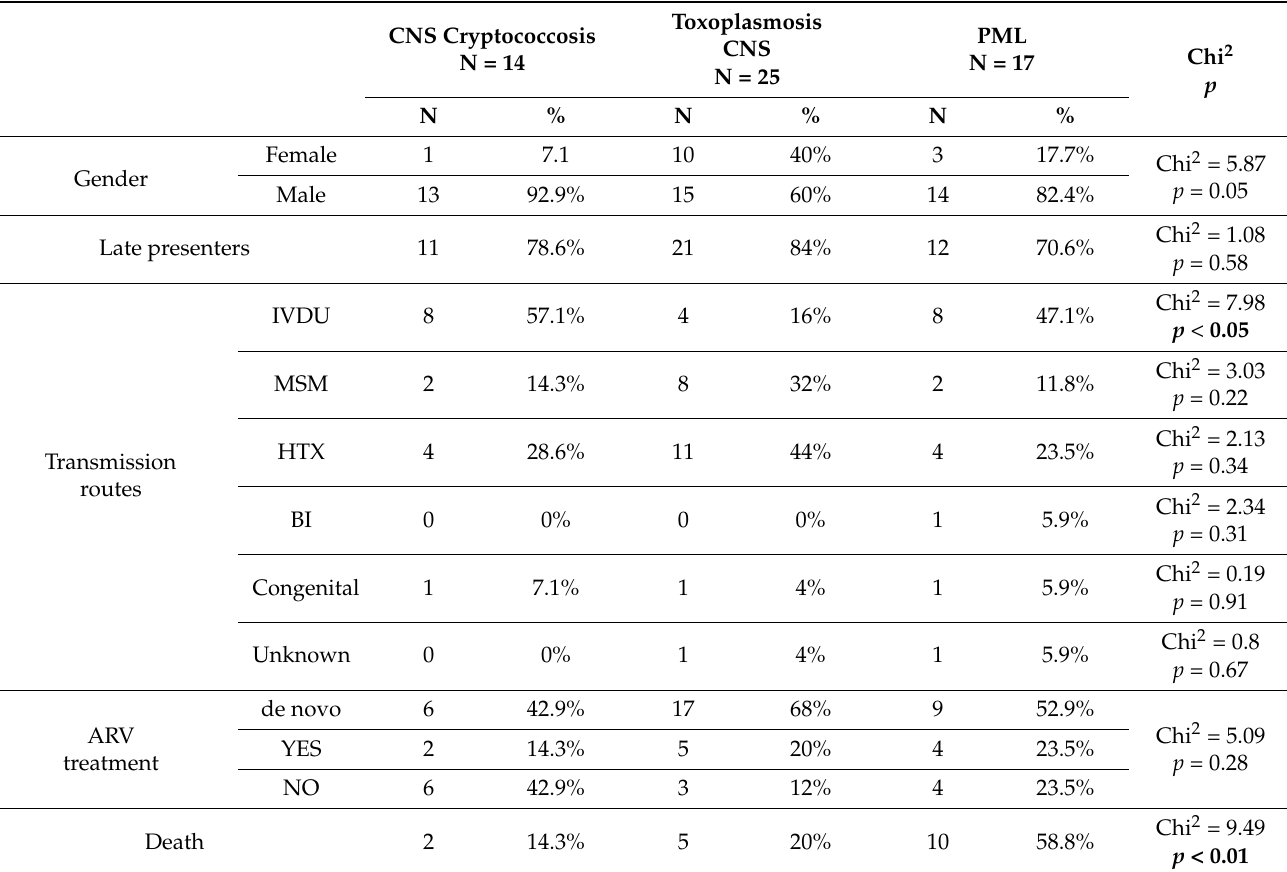
Table 9. Gender distribution, ARV treatment, and the route of HIV infection in particular subgroups of patients with diagnosed CNS